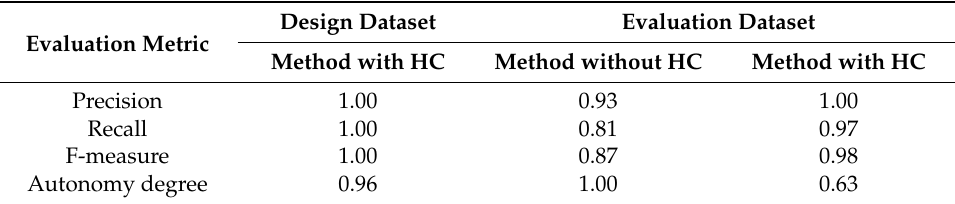
Table 2. Evaluation results of the recognition